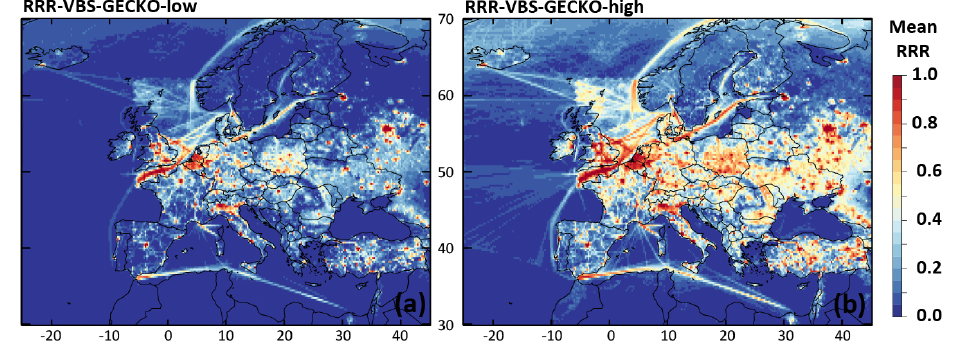
Figure 7. Mean RRR over Europe during the 2-month period for (a) the RRR-VBS-GECKO-low and (b) the RRR-VBS-GECKO-high model configurations.